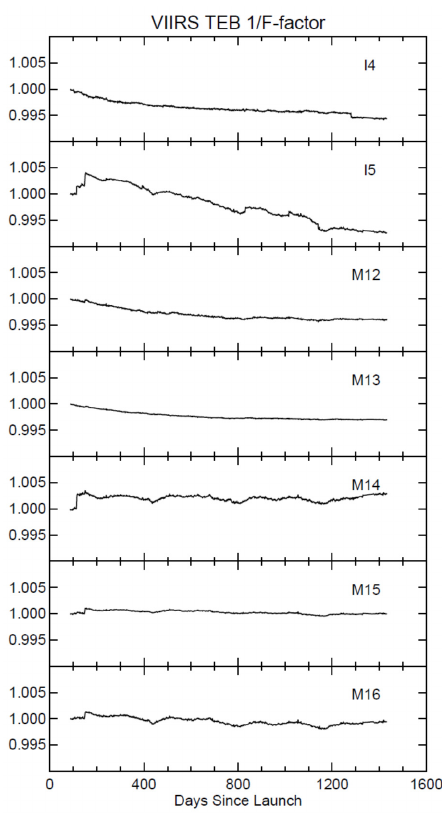
Figure 6. VIIRS TEB band average 1/F-factor trending over the entire mission, normalized to 20 January 2012.